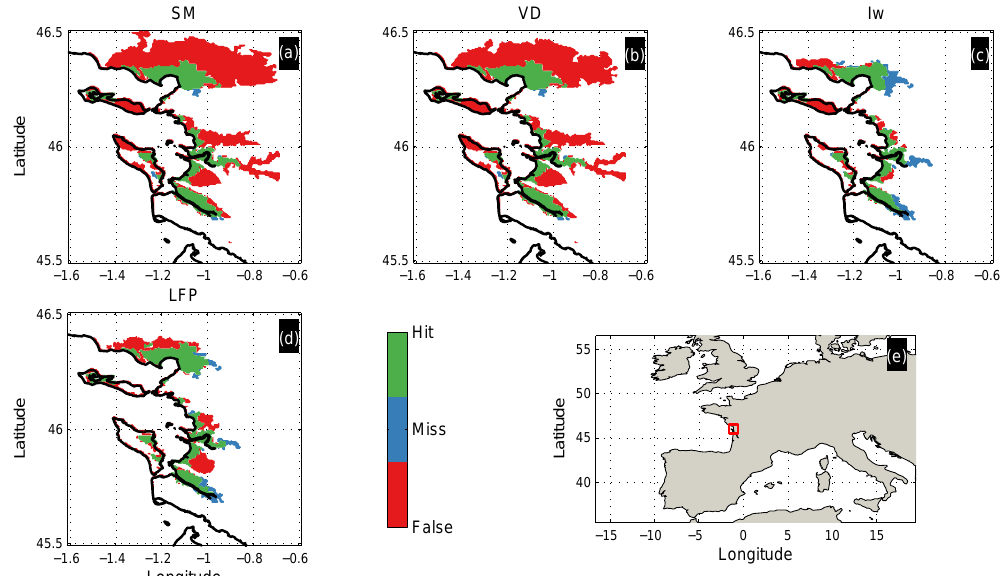
Figure 3. Validation of the LISFLOOD-FP model for the Xynthia storm: maps showing the comparison of the simulated and observed flood extent, as well as their intersection: green, blue and red colors correspond to inundated areas predicted, not predicted and overpredicted by the model, respectively. Map (e) shows the location of the study area.